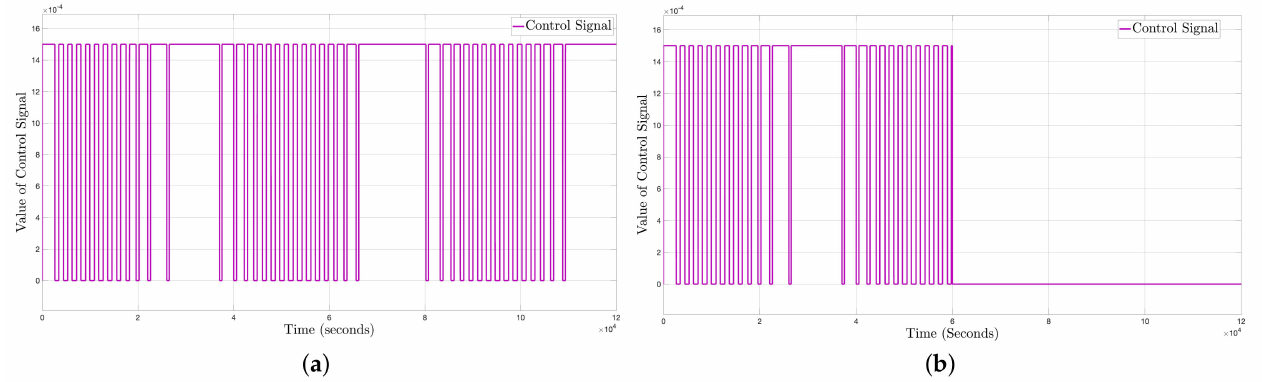
Figure 7. The Control Signal Under Regular and Attack. ( a ) The Control Signal Without Attack.